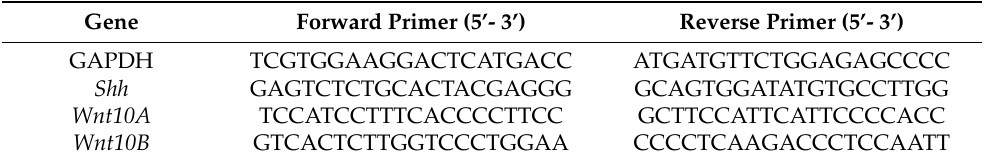
Table 1. DNA sequence of primer pairs used for quantitative real time